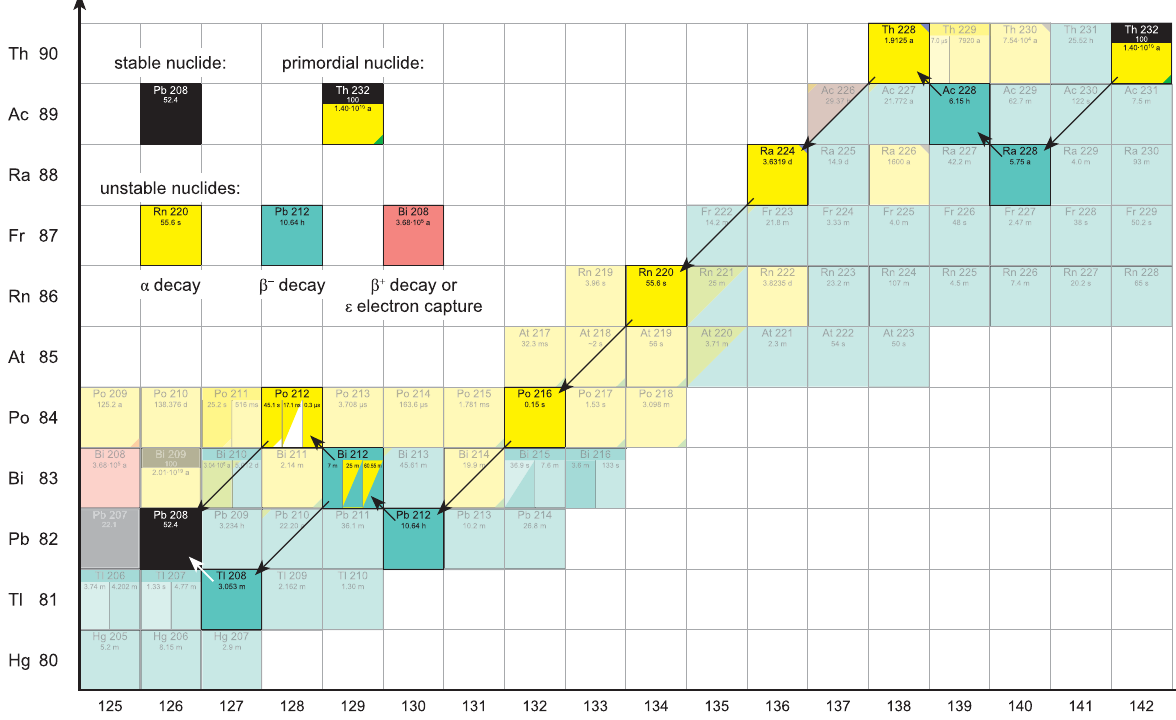
Fig. 10. Highlighted decay chain of Th 232 showing the parent and successive